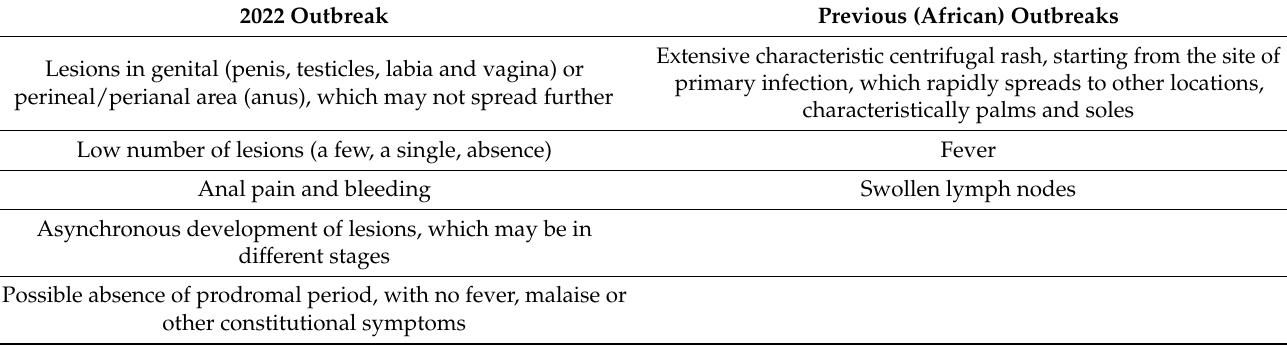
Figure 3. Signs and symptoms among confirmed cases of monkeypox (showed in percentage of presentation). Globally, as of 8 July 2022 [73]. Table 1. Main differences reported in the clinical presentations of monkeypox in patients from the present outbreak and from previous outbreaks. Symptoms in one column do not mean that they cannot be present in the other. However, the frequency of presentation is lower.